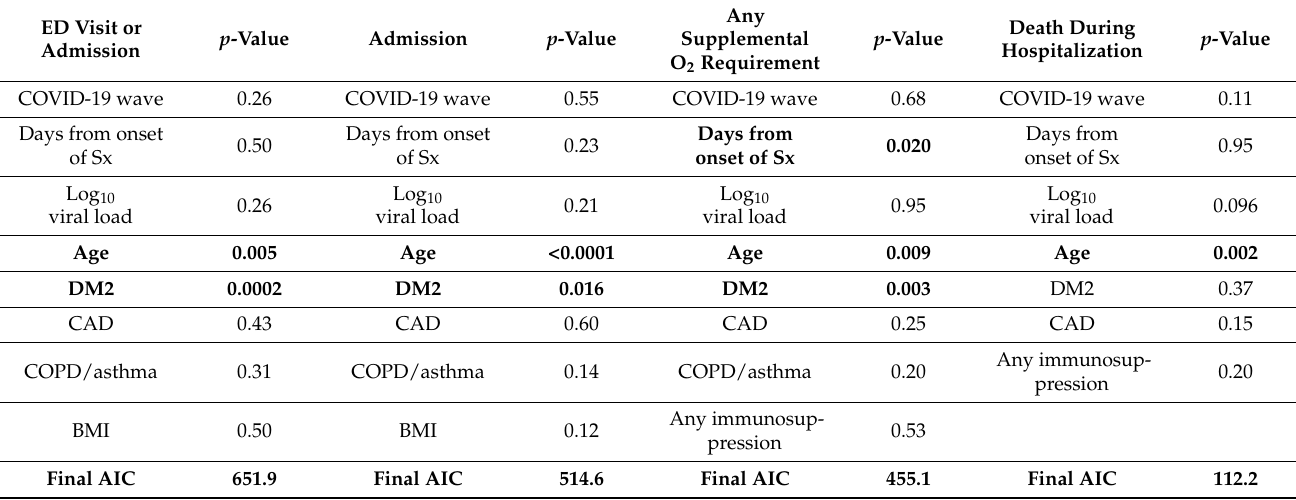
Table 6. Variables included in the final models, including p -values in the multivariate logistic model and final model Akaike information criterion